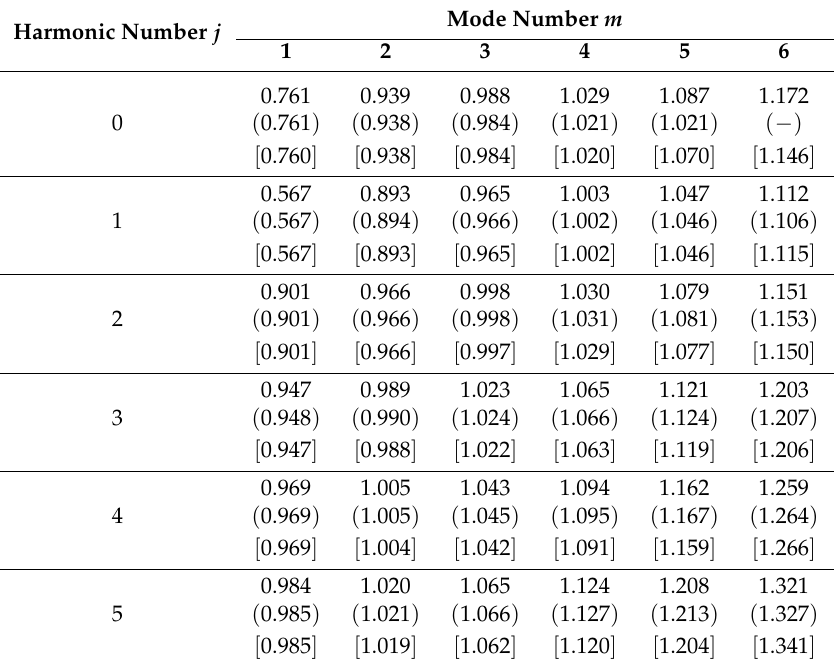
Table 2. Clamped hemispherical shell in free vibration. Non-dimensional frequency